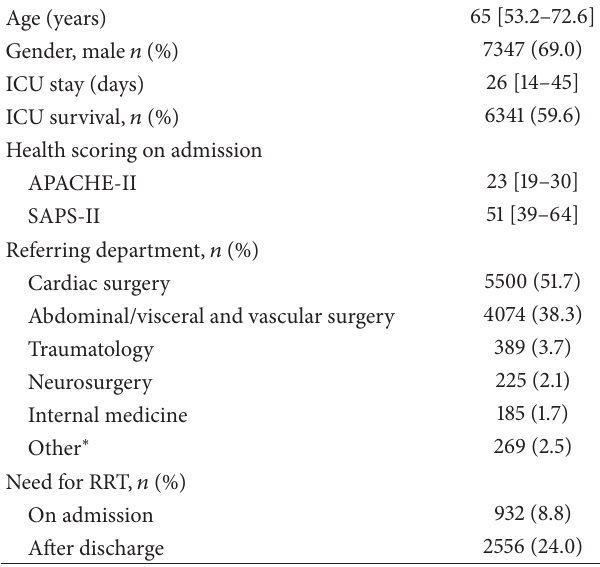
Table 1: Characteristics of patients on renal replacement therapy on ICU